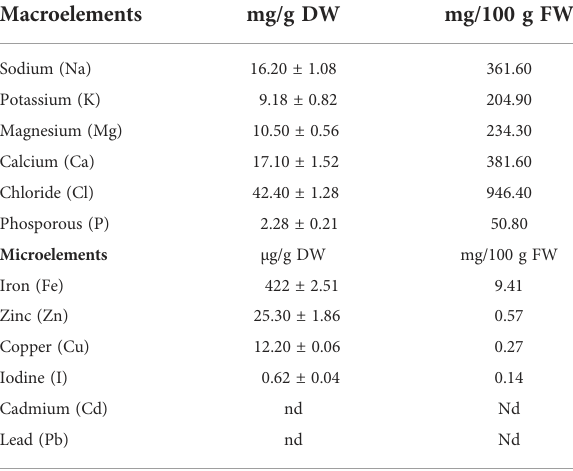
TABLE 2 Mineral composition of leaves of Limonium spathulatum